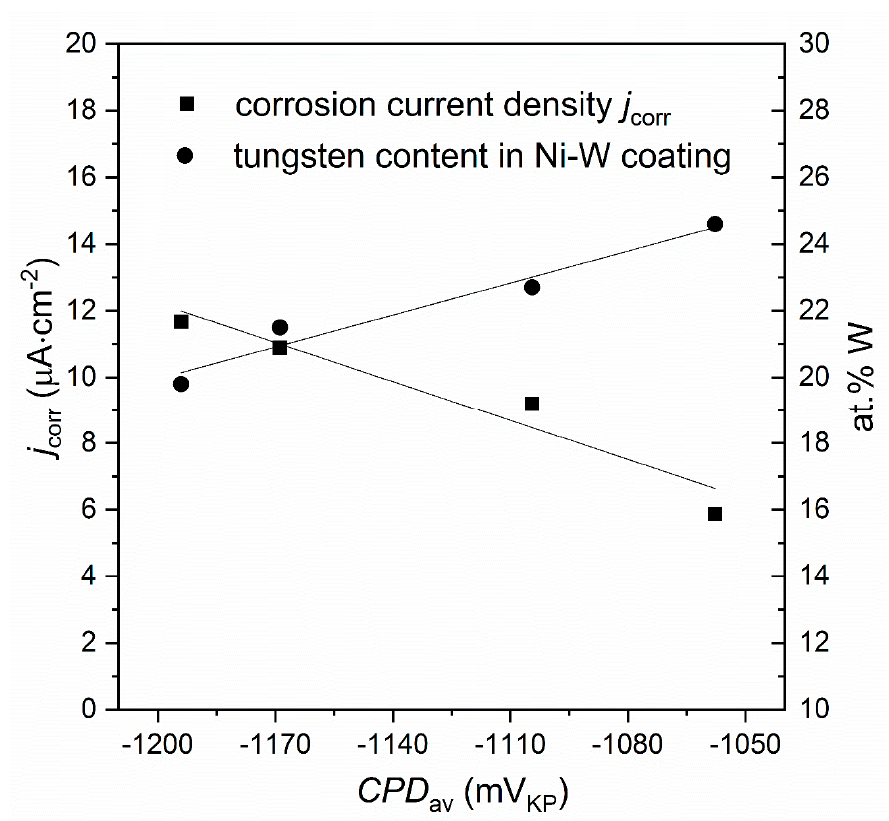
Figure 7. Tungsten content (at.%) and corrosion current density ( j corr ) versus average contact potential di ff erence ( CPD av ) determined for the Ni-W coatings; mV KP is the voltage measured in relation to the Kelvin probe.